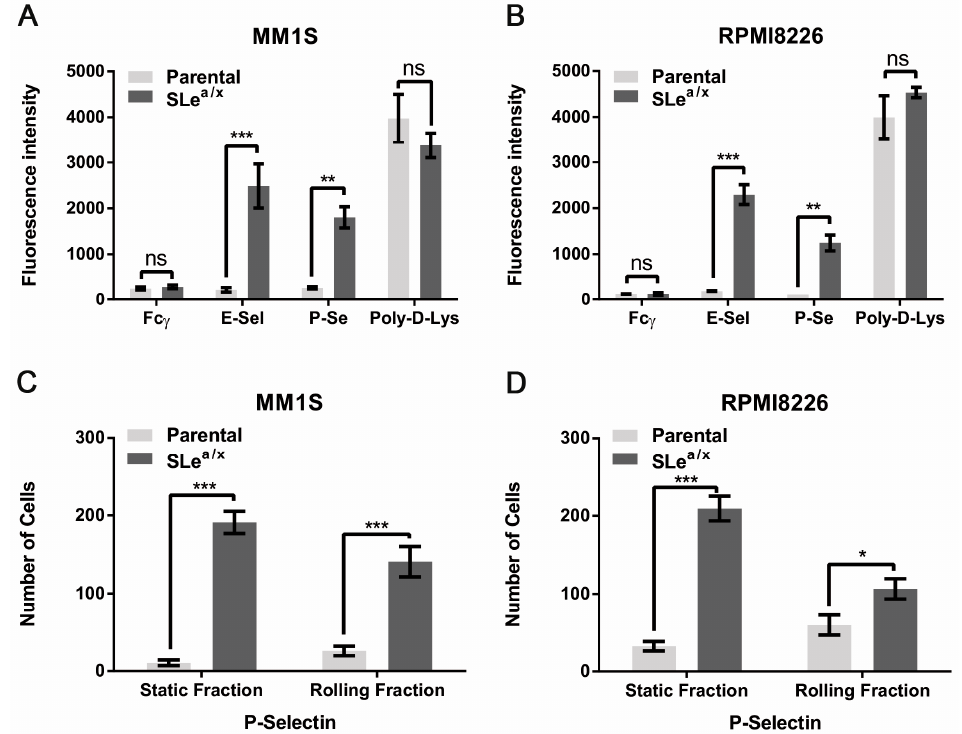
Figure 1. SLe a/x -enriched MM cells exhibit robust and specific adhesion and rolling on recombinant P-selectin. ( A , B ) Static adhesion assay was performed using Calcein-AM labeled parental and SLe a/x - enriched MM1S ( A ) and RPMI8226 ( B ) cells on wells coated with recombinant E- and P-selectin chimera (5 µ g/mL). Wells coated with IgG Fc γ (5 µ g/mL) and poly-D-lysine (Poly-D-Lys; 0.1% in H2O) were used as negative and positive controls, respectively. Fluorescence intensity was measured at 500–550 nm using a GloMax Discover microplate reader. Bars represent the mean ± standard error of the mean (sem) of three independent experiments performed in triplicate. ( C , D ) Parental and SLe a/x -enriched MM1S ( C ) and RPMI8226 ( D ) were tested in a rolling assay on recombinant P-selectin chimera (15 µ g/mL). Bars represent mean ± sem of three independent experiments performed in duplicate. The two-way ANOVA followed by Sidak’s multiple comparison post-hoc testing was used to determine the statistical significance. *** p < 0.001; ** p < 01; * p < 0.05; ns non-signif- icant.